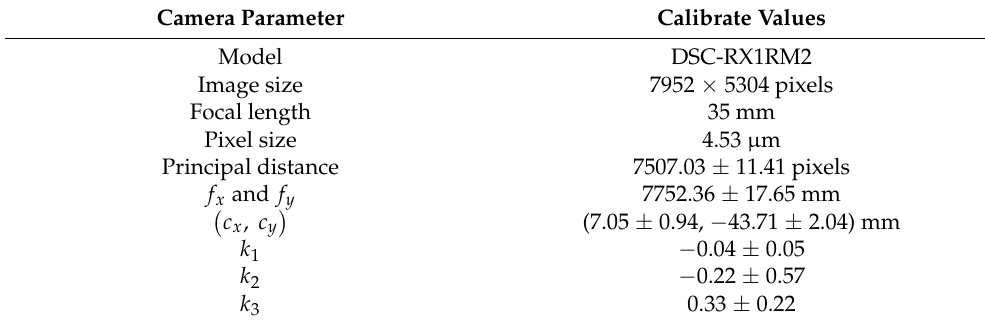
Table 1. Camera calibration